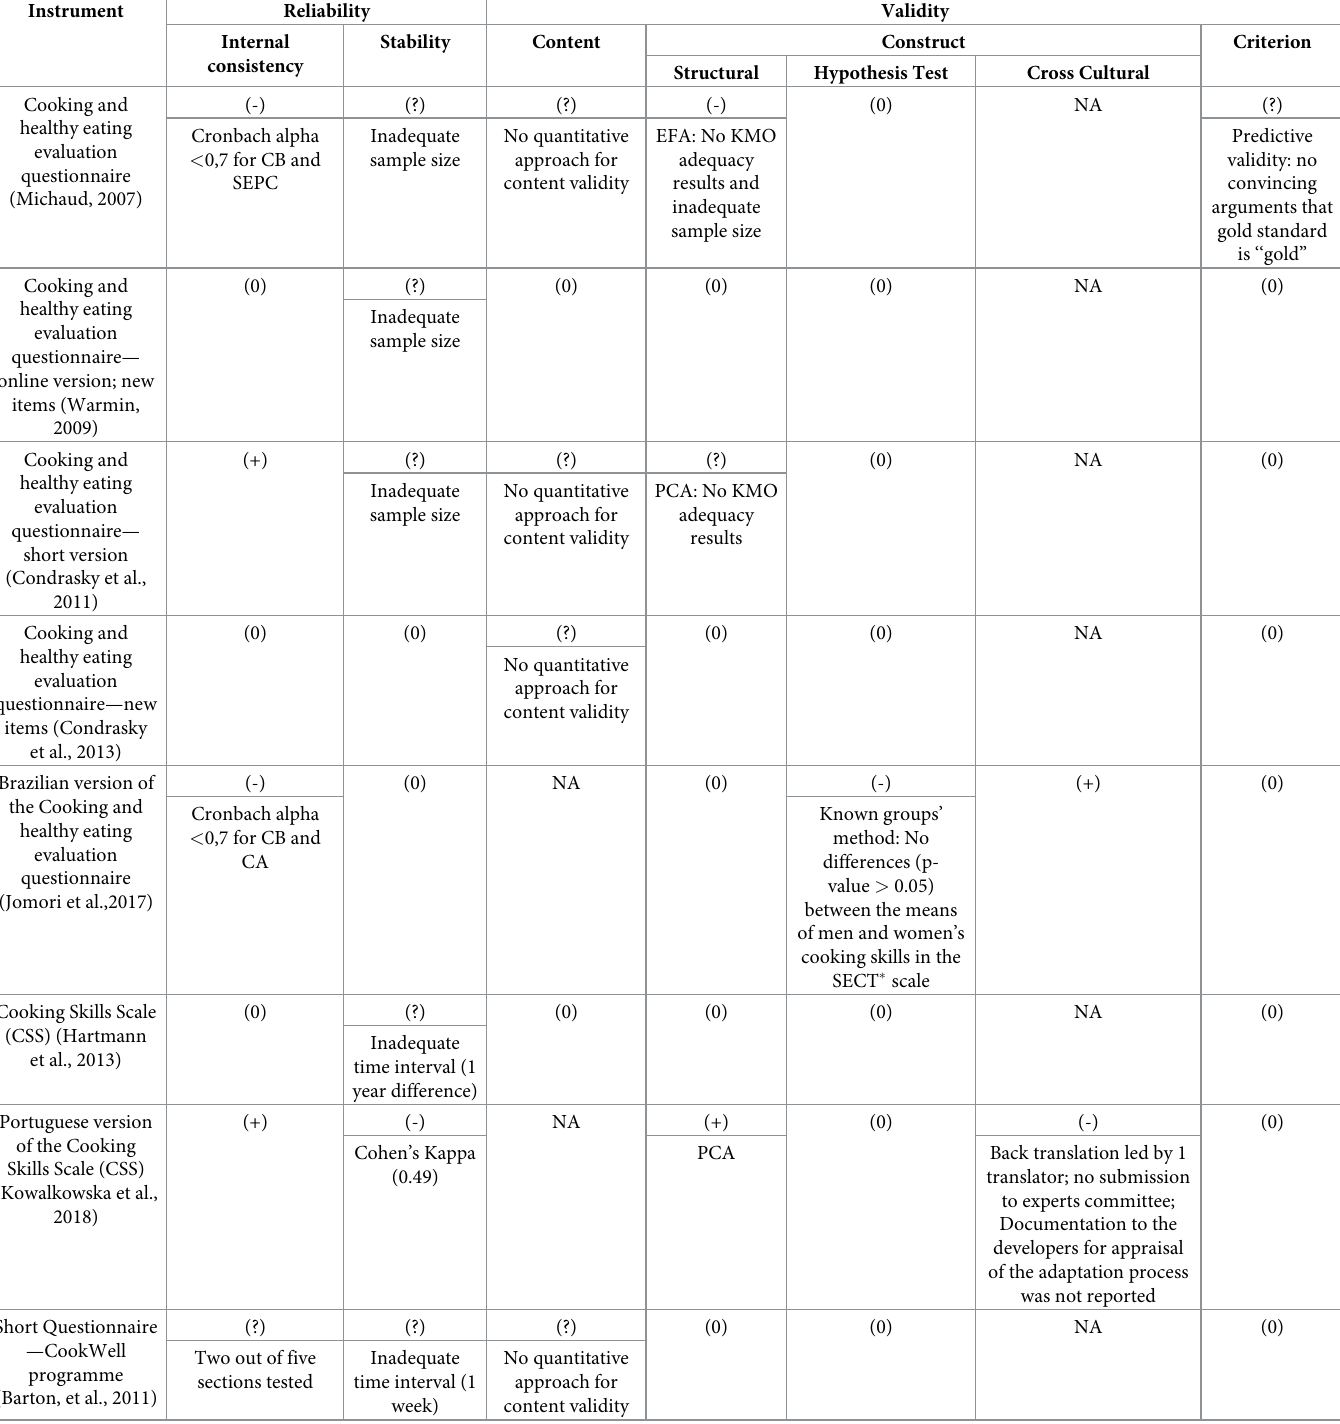
Table 4. Evaluation of quality of psychometric properties of the